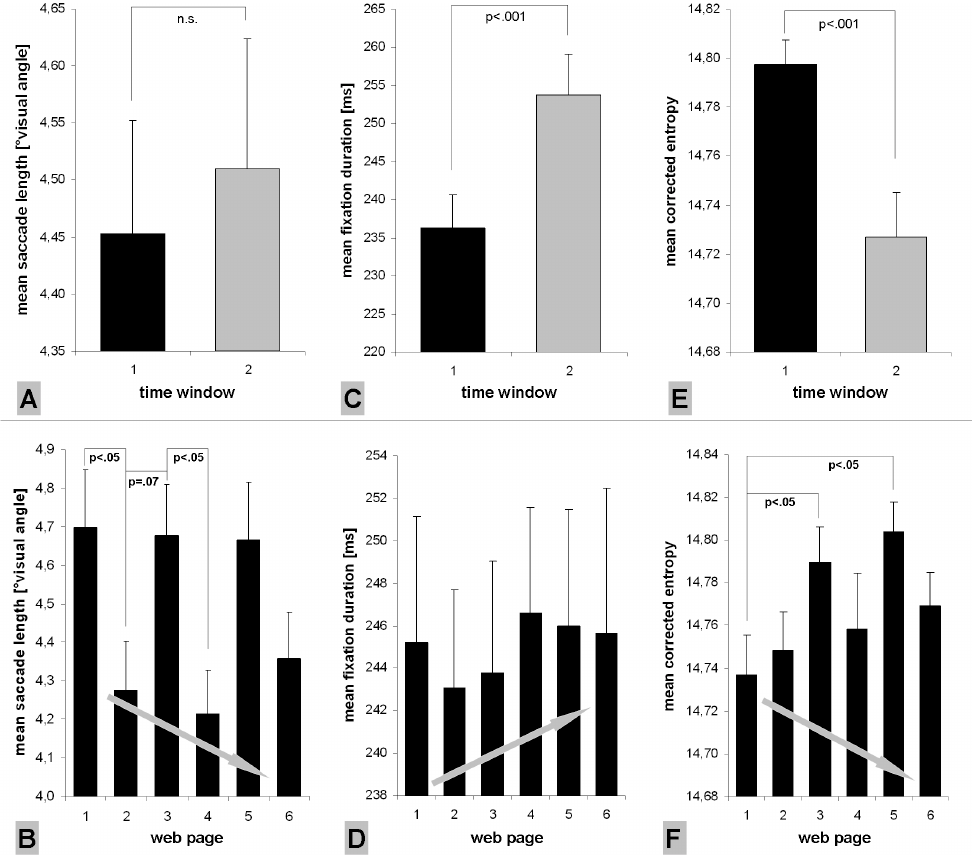
Figure 3. Main effects of factors “time-window” (upper row) and “web page” (lower row) on eye movement parameters (from left to right: saccade length, fixation duration and entropy). Time window 1 comprises the first six seconds of presentation duration, time window two the following six seconds. For results of the factor “web page,” grey arrows within the diagrams depict the predicted direction of change in eye movement parameters across web pages. All significant effects are denoted. Vertical lines on top of bars indicate standard error of the mean. Significant differences between factor levels (post-hoc Bonferroni adjusted t-tests) are marked.